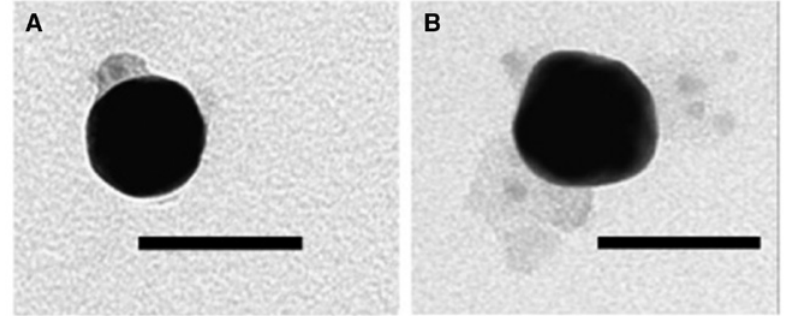
Figure 5: AuNPs attached to PI-b-PEG coated CdSe QDs through thiol ligand-induced self-assembly. (A) Polymer shell is 10 nm thick. (B) Polymer shell is 15 nm thick. Scale bars are 50 nm. Adapted with permission from Ref. [39]. Copyright 2016 American Chemical